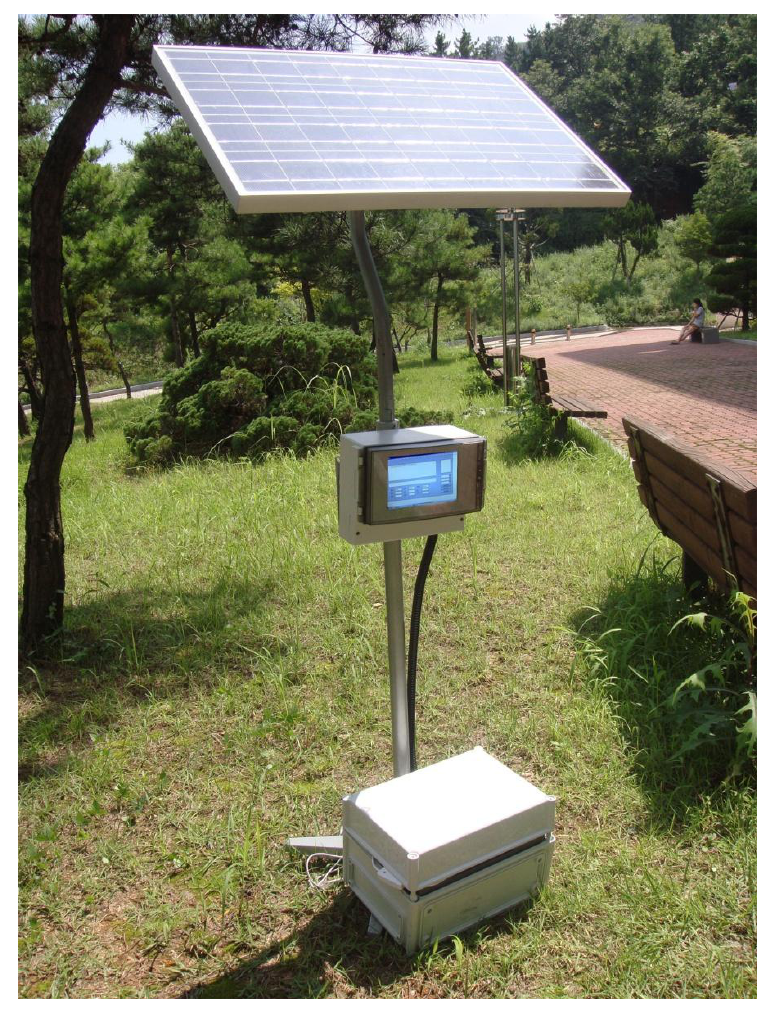
Figure 12. Prototype Version 2 of Agricultural Environment Monitoring Server